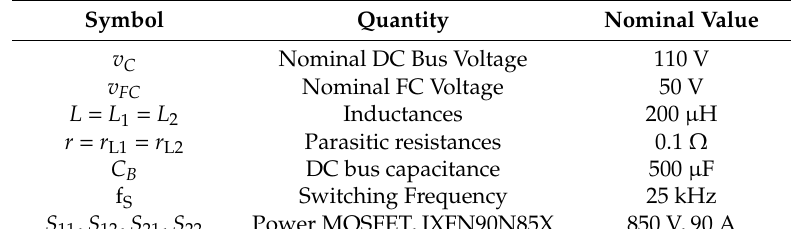
Table A1. Fuel cell converter parameters.